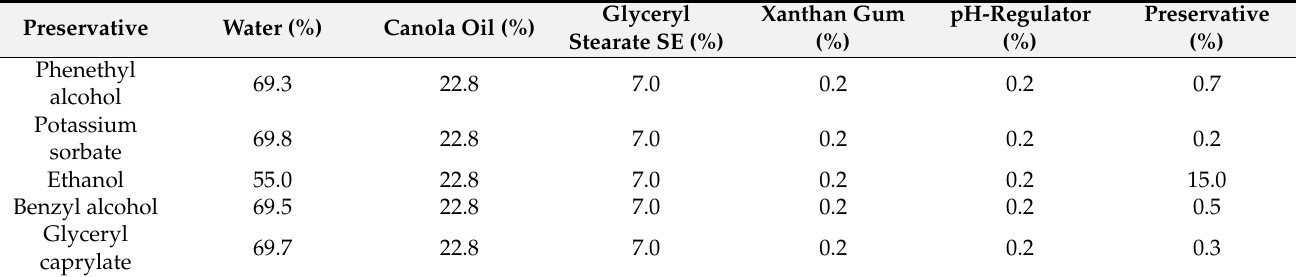
Table 2. Overview of the formulations used.